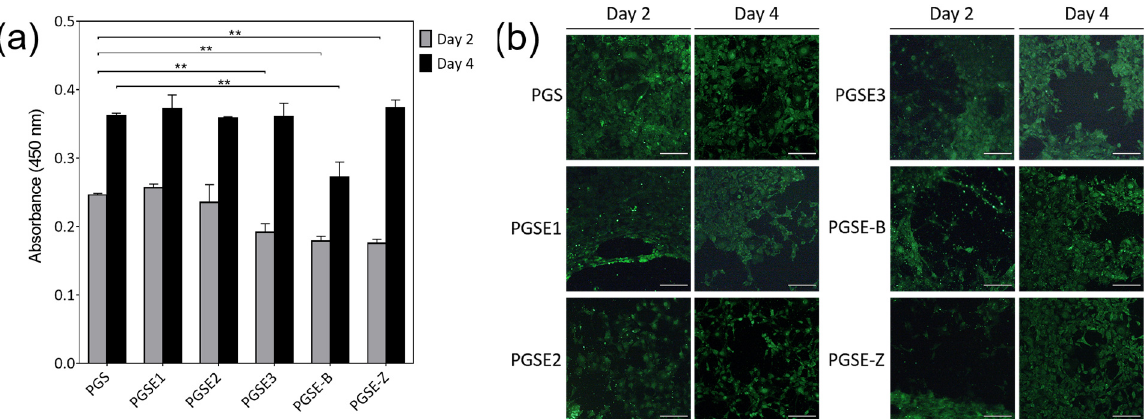
Figure 9. ( a ) Growth of NIH/3T3 co-cultured with PGS, PGSE1, PGSE2, PGSE3, PGSE-B, or PGSE-Z (** means p < 0.001). ( b ) Representative immunofluorescence images of the corresponding cells stained for GAPDH (scale bar = 100 μ m).